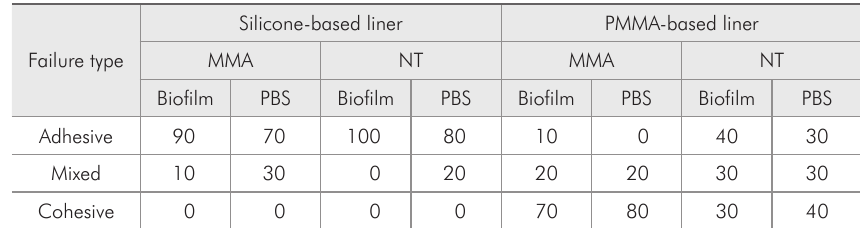
Table 3 - Surface roughness (mean ± SD, µ m) of soft liners at baseline and after biofilm accumulation or PBS storage.